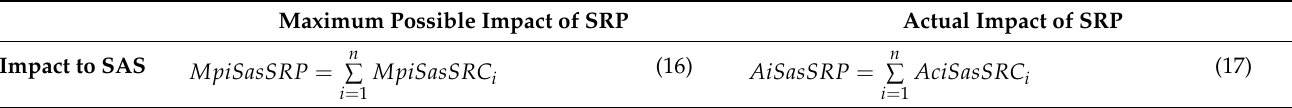
Table 6. Security requirement impact metrics (for SRP).